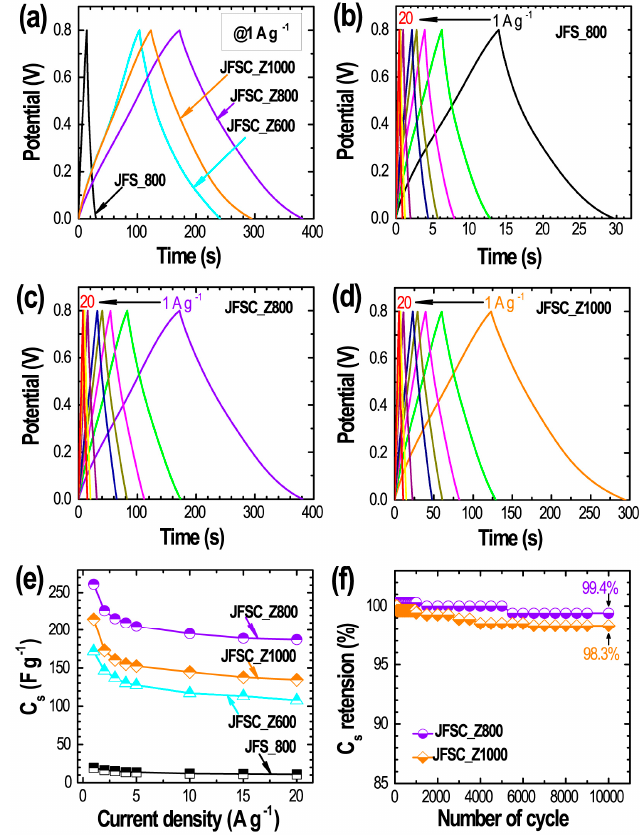
Figure 6. ( a ) Comparison of charge–discharge (CD) profiles of Jackfruit seed nanoporous carbons